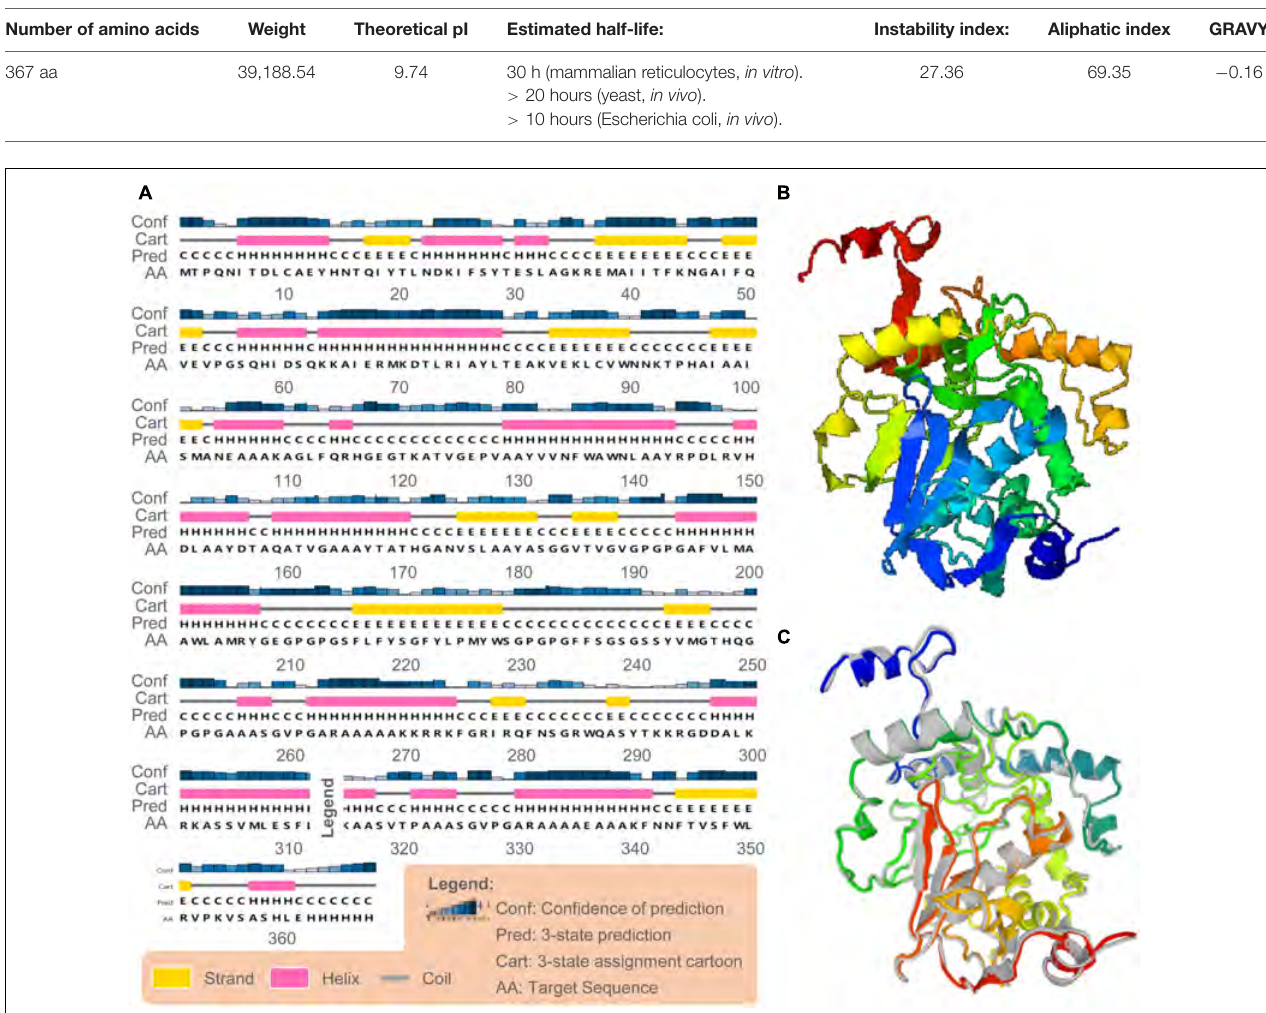
FIGURE 3 | Secondary and tertiary structure prediction of the C543P candidate. (A) The C543P candidate was predicted to contain 43.6% α -helices, 15.8% β -strand, and 40.6% random coils by the PSIPRED server. (B) The 3D model of the C543P candidate was obtained on the I-TASSER server. (C) The 3D model of the peptide molecule after optimization by the Galaxy refining server, and the colored structure was superimposed on the rough gray model.